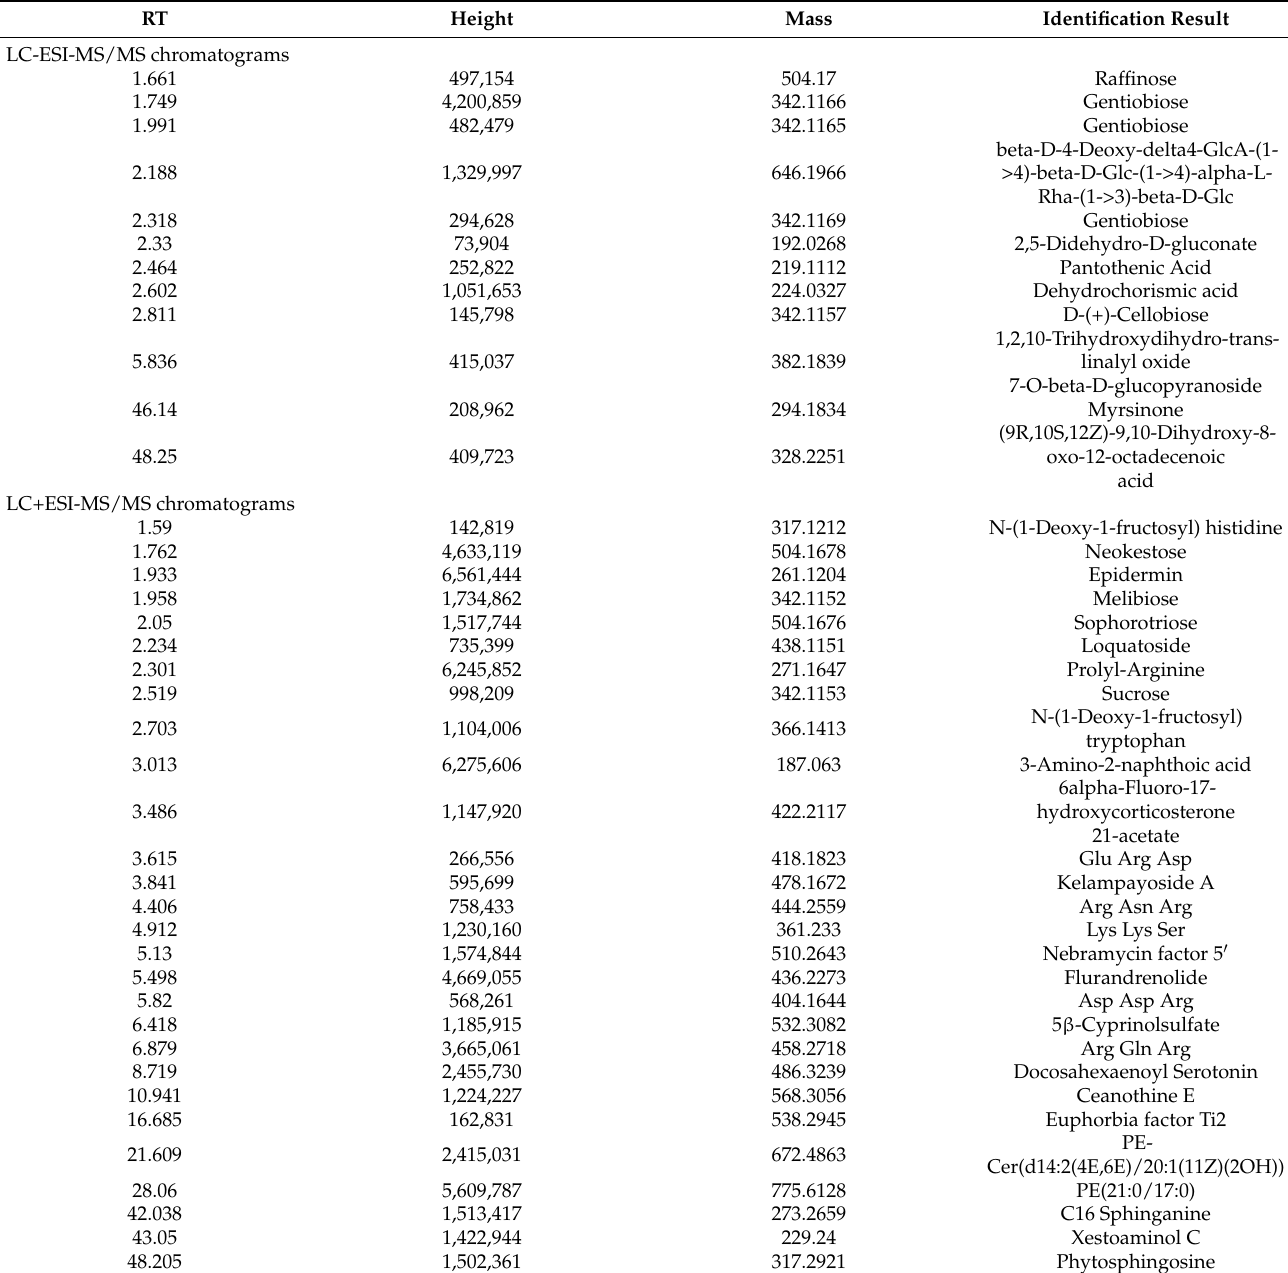
Table 2. Chemical constituents of the D. kaki extract detected in LC-ESI-MS/MS and LC+ESI-MS/MS